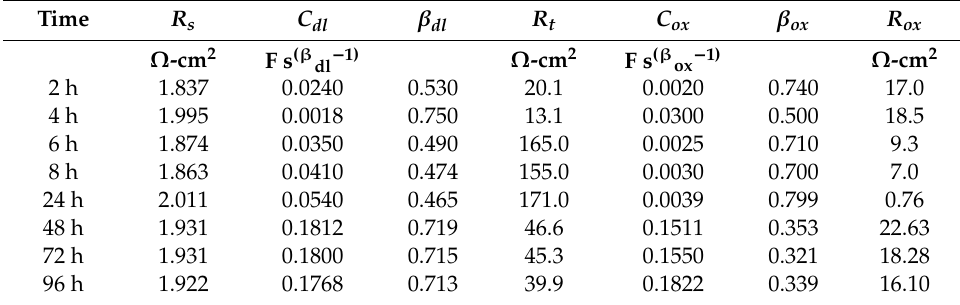
Table 5. Fitting results of the impedance spectra of Nickel alloy HR224 during corrosion in the presence of (KNa)NO 3 (solar salt) at 550 ◦ C.